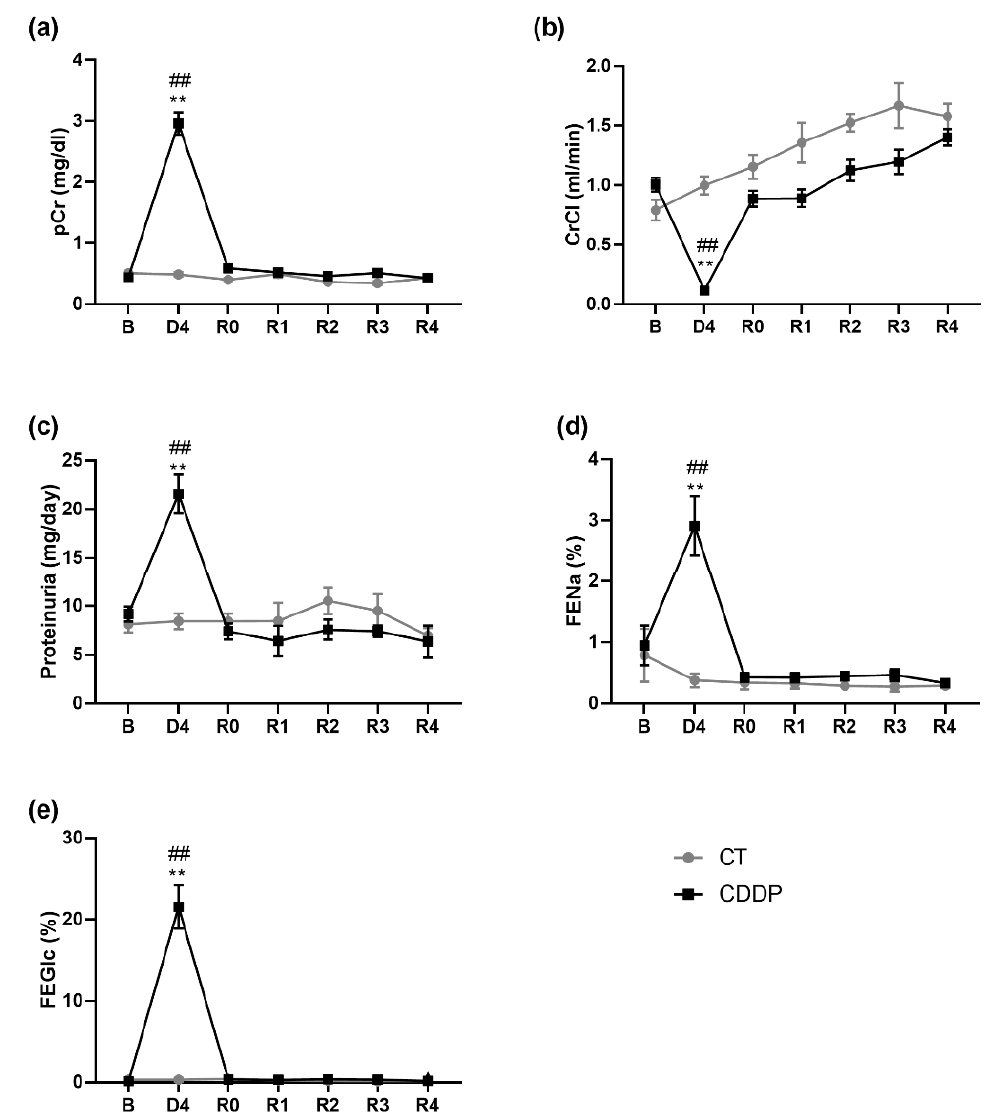
Figure 2. Renal function parameters: plasma creatinine (pCr) ( a ), creatinine clearance (ClCr) ( b ), proteinuria ( c ), fractional excretion of sodium (FENa) ( d ) and fractional excretion of glucose (FEGlc) ( e ). B: basa; CDDP: cisplatin treatment (5 mg · kg − 1 body weight) group; CT: control group; D4: day of maximum kidney damage after cisplatin treatment; R0: day of recovery; R1: 1 week after recovery; R2: 2 weeks after recovery; R3: 3 weeks after recovery; R4: 4 weeks after recovery. ** p < 0.01 vs. B; ## p < 0.01 vs. CT.